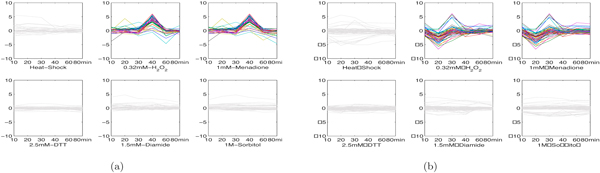
Two H2O2-menadione modules in yeast. (a) genomic expression of module 1; (b) genomic expression of module 2.